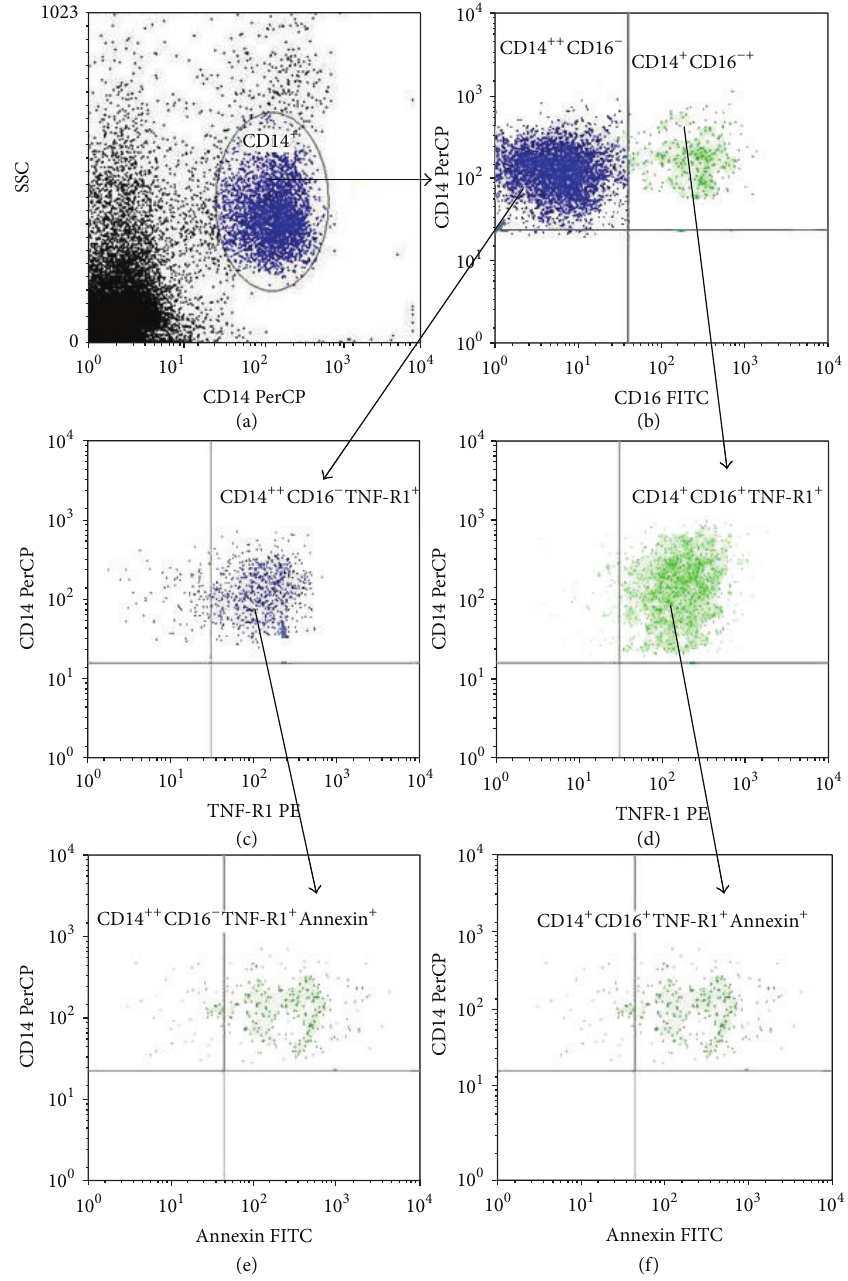
Figure 4: Gating strategy used to analyze apoptosis of monocyte subsets. The monocyte subset was identified according to the expression of the CD14 molecule and SSC parameter (a). Based on the expression of the CD14 and CD16 molecules, two monocyte subsets were distinguished: CD14 ++ CD16 − and CD14 + CD16 + cells (b). Monocytes in CD14 ++ CD16 − (c) and CD14 + CD16 + (d) gates were gated on TNF-R1 + cells. Plots (e) and (f) show apoptotic Annexin V-positive CD14 ++ CD16 − TNF-R1 + and CD14 + CD16 + TNF-R1 + cells,